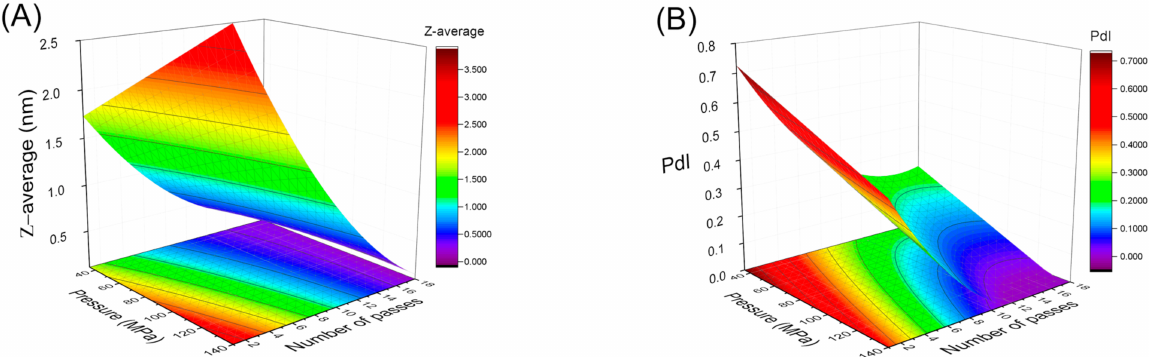
Figure 3. Response surface 3D plot of ( A ) droplet mean diameter and ( B ) polydispersity index as a function of the number of passes and homogenization pressure for emulsions aged for 24